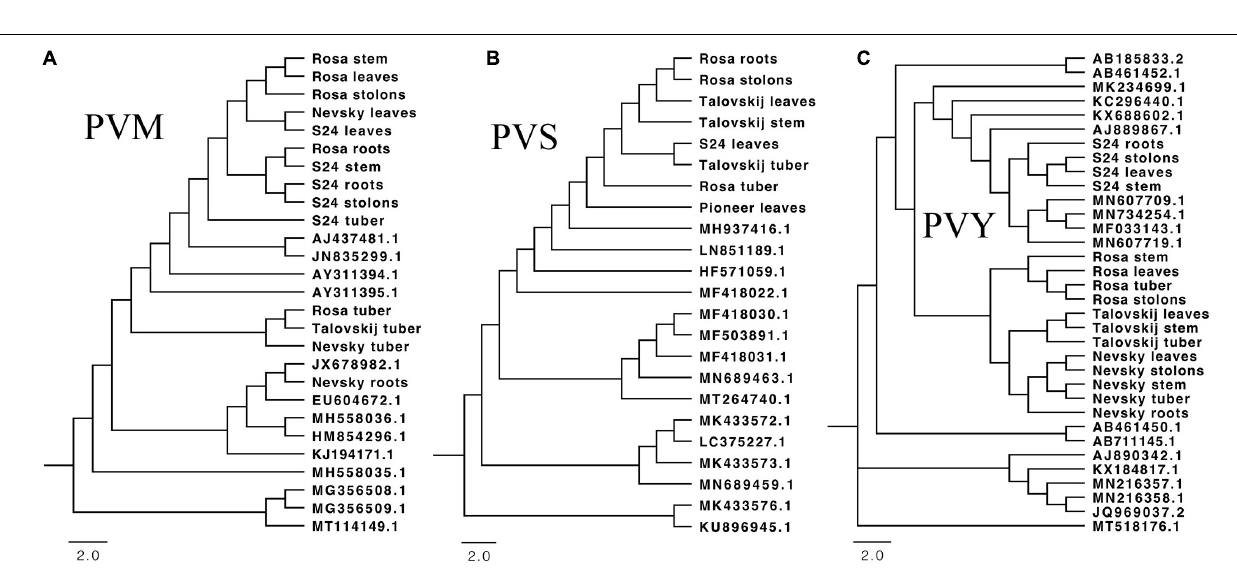
Frontiers in Microbiology |